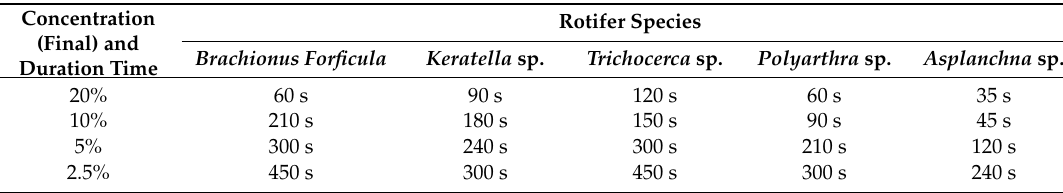
Table 3. The responses of rotifers lorica to commercial bleach treatment; the minimum time (s) before the loss of the rotifers contents by lorica disintegration of each rotifers